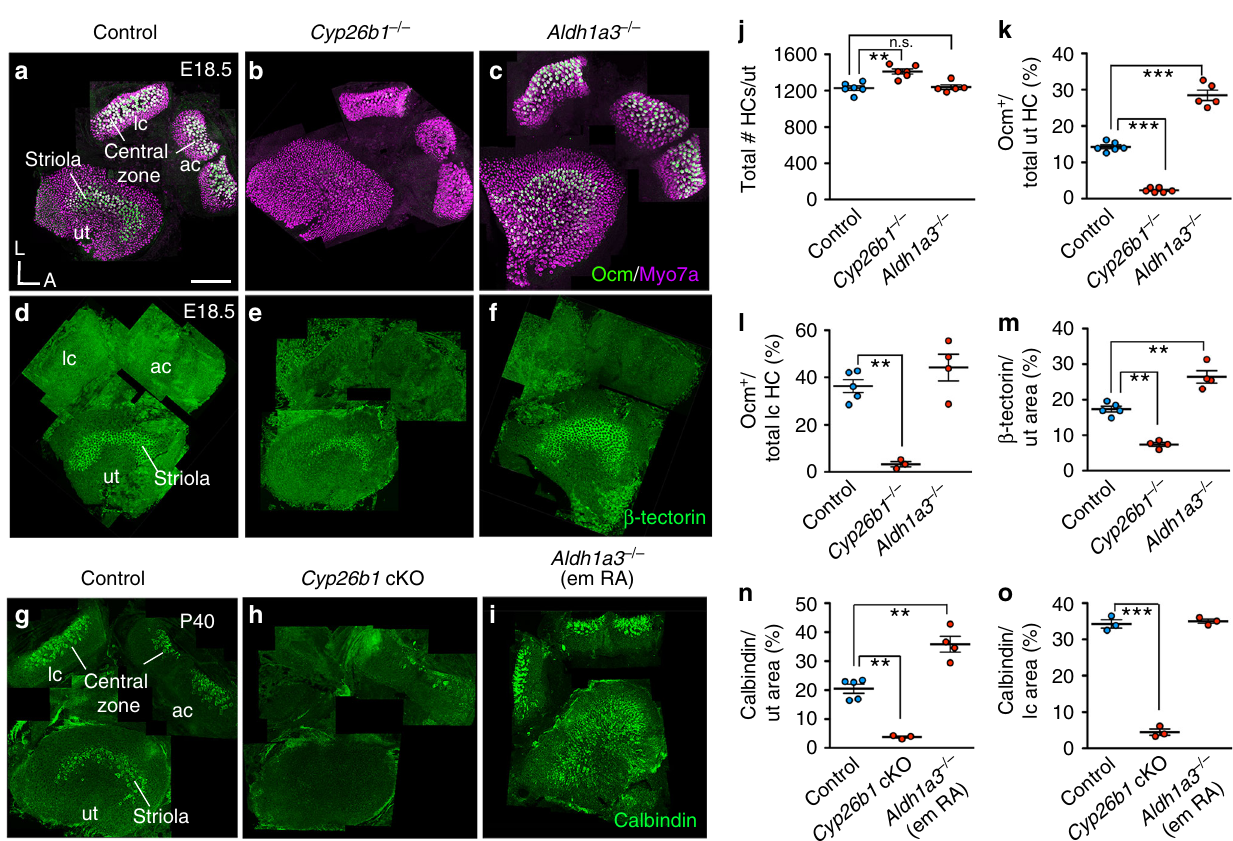
Fig. 2 Disruption of RA signaling alters striolar/central zone formation. a Oncomodulin (Ocm) is expressed in type I HCs in striolar/central zones, whereas all HCs are positive for Myosin7a of controls. b , c , j Total HC number is increased in Cyp26b1 − / − (1394 ± 39, P = 0.014, n = 6), but unchanged in Aldh1a3 − / − utricles (1285 ± 28, P = 0.419, n = 5), compared to controls (1229 ± 30, n = 6). b , c , k Percentages of Ocm + HCs (14.3 ± 0.5 in controls, n = 6) are decreased in Cyp26b1 − / − (2.3 ± 0.2, n = 6, p < 0.0001) and increased in Aldh1a3 − / − utricles (28.4 ± 1.4, n = 5, P < 0.0001). b , c , l Percentages of Ocm + HCs in lateral cristae (lc, 36.2 ± 2.7 in controls, n = 5) are reduced in Cyp26b1 − / − (3.2 ± 1.1, n = 3, P = 0.0005), but unchanged in Aldh1a3 − / − mutants (44.1 ± 5.6, n = 4, P = 0.302). d Anti- β -tectorin labels SCs in striolas of utricles. e , f , m β -tectorin + domain, as % of total utricular macular area (17.4 ± 0.9 in controls, n = 5), is reduced in Cyp26b1 − / − (7.4 ± 0.6, n = 4, P = 0.0002) and increased in Aldh1a3 − / − (26.4 ± 1.7, n = 4, P = 0.0003) utricles. g Anti-calbindin labels calyceal nerve endings in striolar/central zones. h , i , n , o Expression and percentage of calbindin-positive area is reduced in utricles (3.8 ± 0.3, n = 3, P = 0.0005) and cristae (4.7 ± 1.4, n = 3, P < 0.0001) of Cyp26b1 cKO, but increased in utricles (36.0 ± 6.6, n = 4, P = 0.0006) and unchanged in cristae (34.4 ± 0.5, n = 3, P = 0.3021) of Aldh1a3 − / − (em RA) mutants, compared to respective controls ( n , 19.7 ± 1.7, n = 5; o , 34.2 ± 1.1, n = 3). Error bars: SEM. Signi fi cance was assessed by one-way ANOVA for all panels. A, anterior; L, lateral. ** P < 0.01 and *** P < 0.001. n.s., not signi fi cant. Scale bar: 200 μ m.